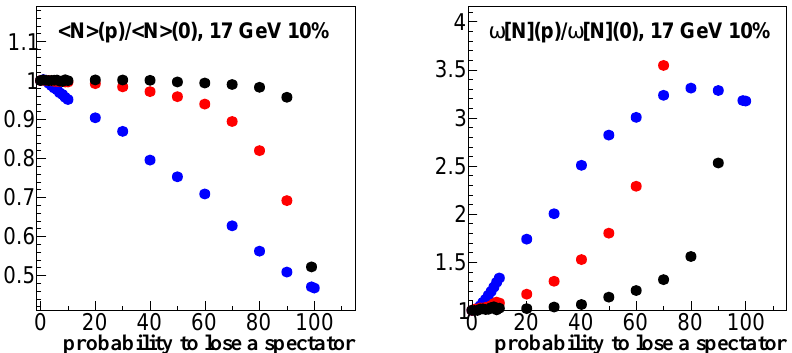
Figure 6. Ratios of multiplicity and scaled variance to values with a zero probability to lose a forward spectator for Li + Be (blue), Cl + Ca (red) and Pb + Pb (black) collisions. WNM with a centrality selection based on the number of detected forward spectators.